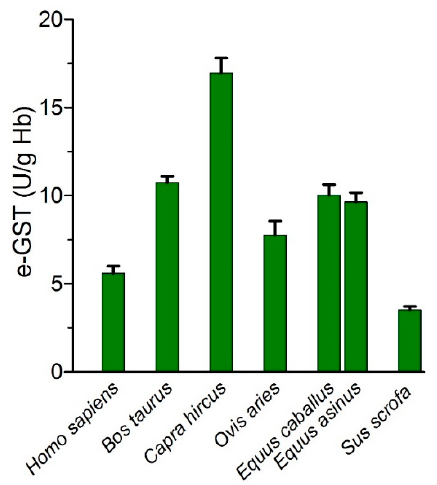
Figure 11. Erythrocyte glutathione transferase (e-GST) activity in some mammalian species. e-GST activity in selected mammalian species usually reared in farm and with a veterinary relevance compared to healthy human subjects ( H. sapiens ) (modified from Reference [194] ). Table 3. A comparison of the kinetics parameters of mammalian e-GSTs (modified from Reference [194] ).